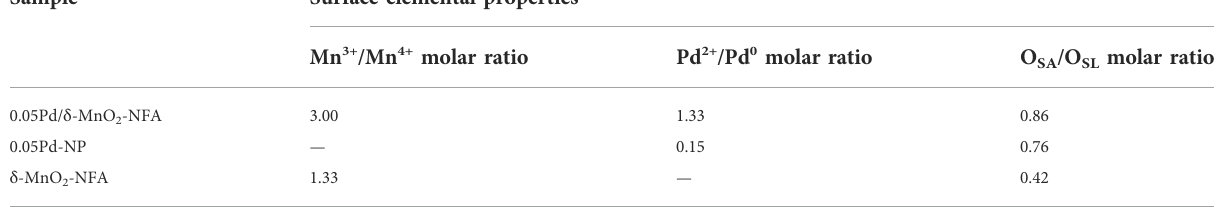
TABLE 3 Surface elemental properties of the monolithic samples.